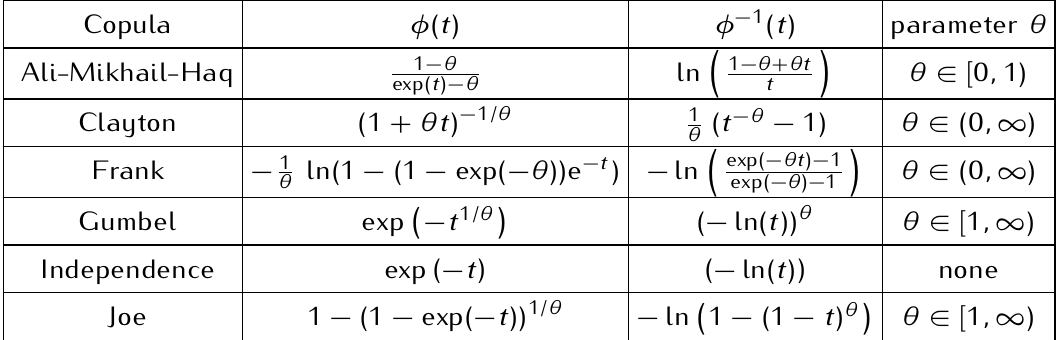
Table 1. Classical generators and their associated inverses in the case of most popular Archimedean families of copulas. Copula